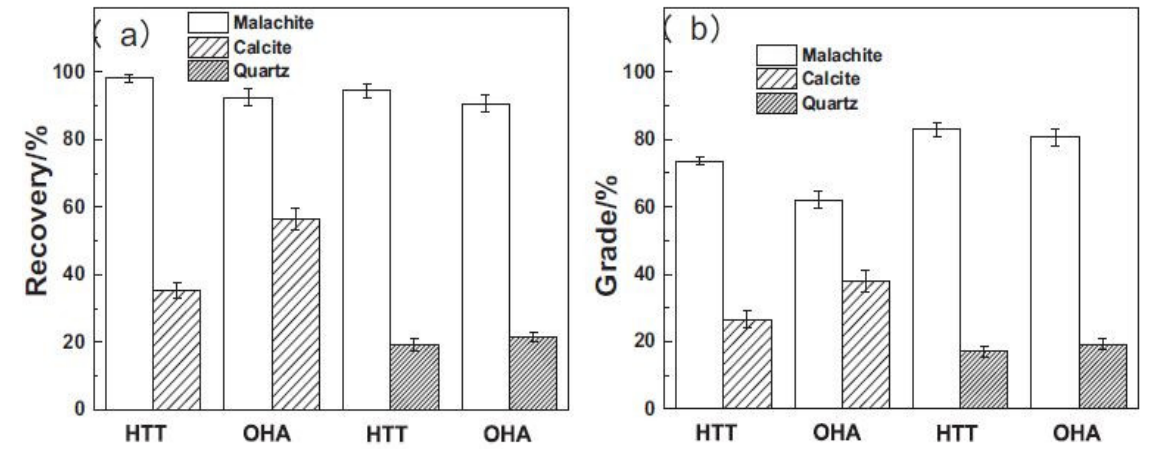
Figure 15. Bubble contact angle measurement of malachite surfaces as a function of different ( a ) pH and ( b ) collector dosages (HTT-6-hexyl-1,2,4,5-tetrazinan-3-thione, PrTT-6-propyl-1,2,4,5-tetrazinan-3-thione, PhTT-6-phenyl-1,2,4,5-tetrazinan-3-thione and OHA- octyl hydroxamic acid) [97].